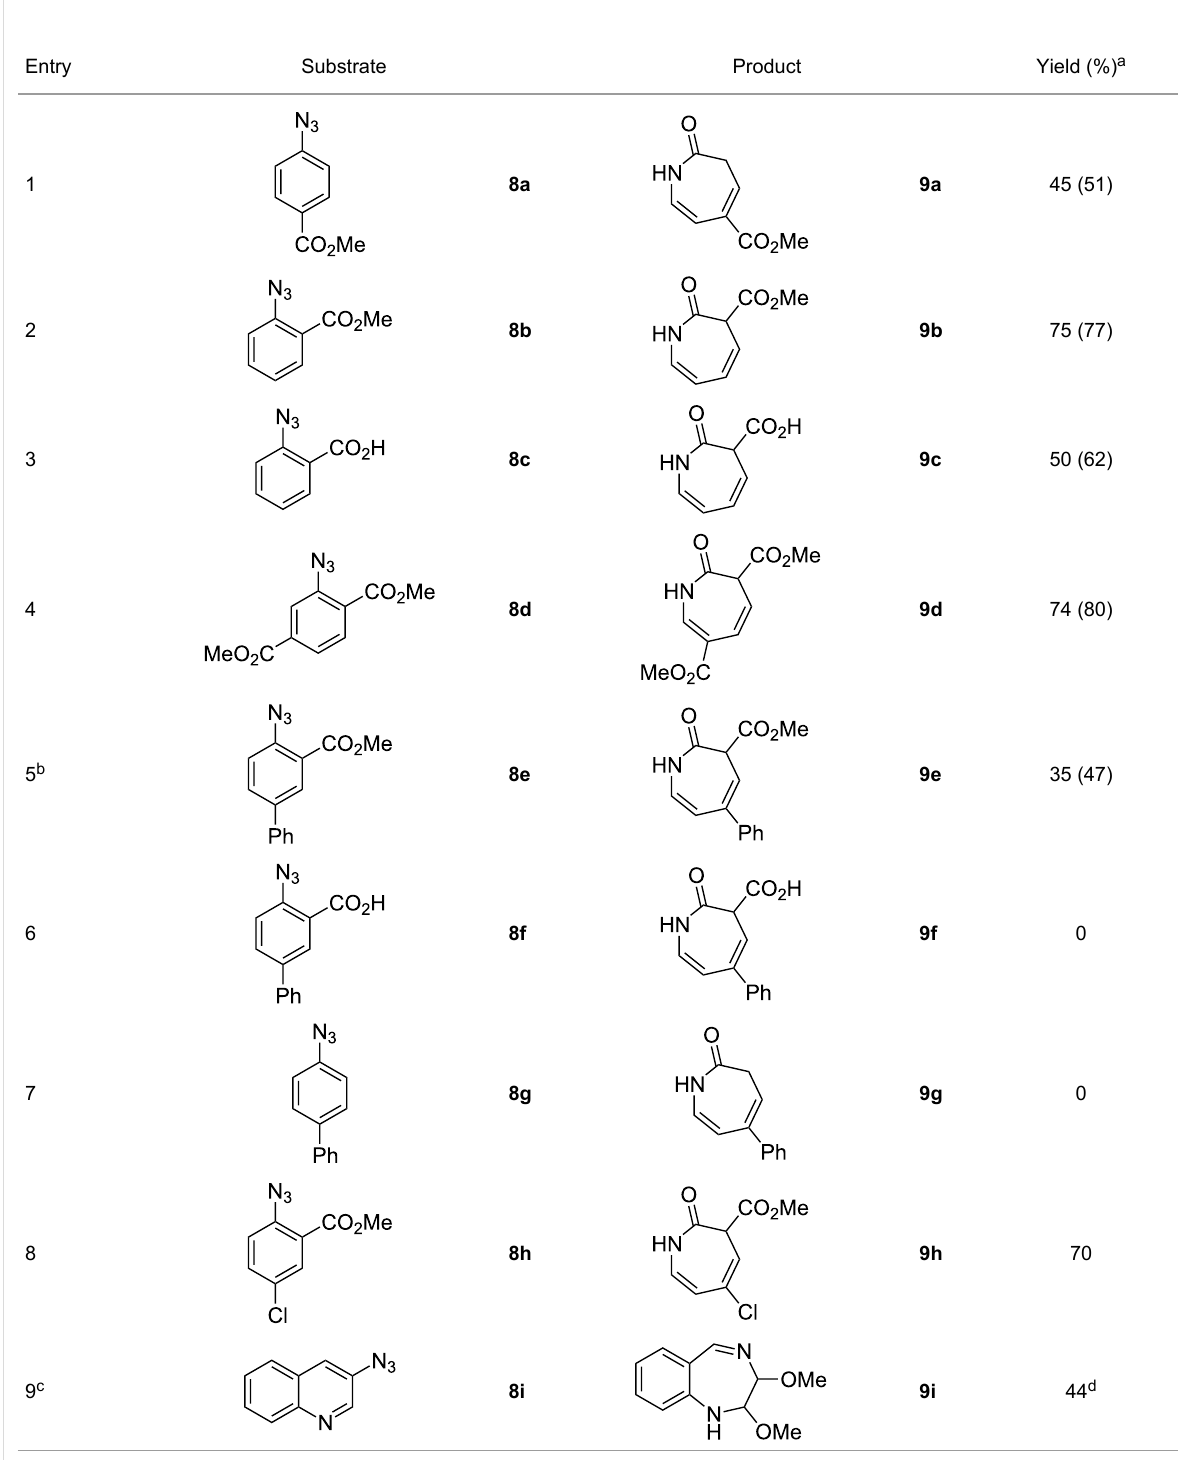
Table 2: 3 H -azepinone derivatives prepared by photolysis of aryl azides in continuous